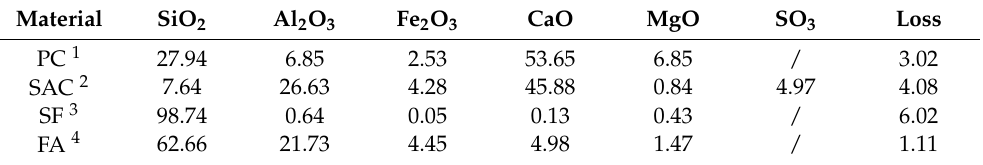
Table 1. Chemical composition of cementitious materials (wt.%).